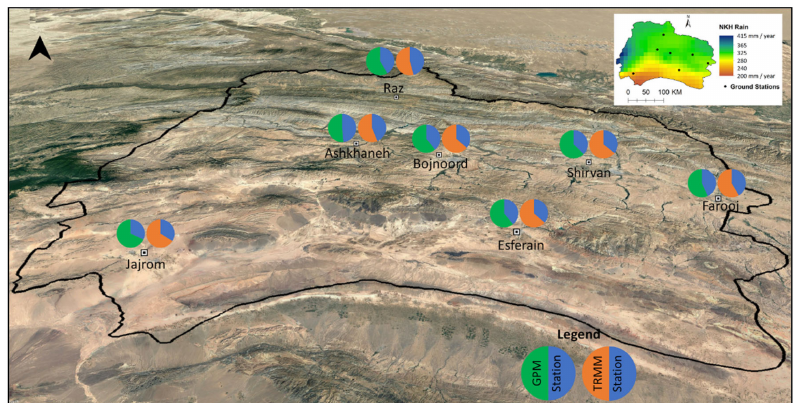
Figure 7. Precipitation correction coefficient for North Khorasan. The legend is shown when satellite and station have an equal amount. The image is tilted to create a 3D perspective.